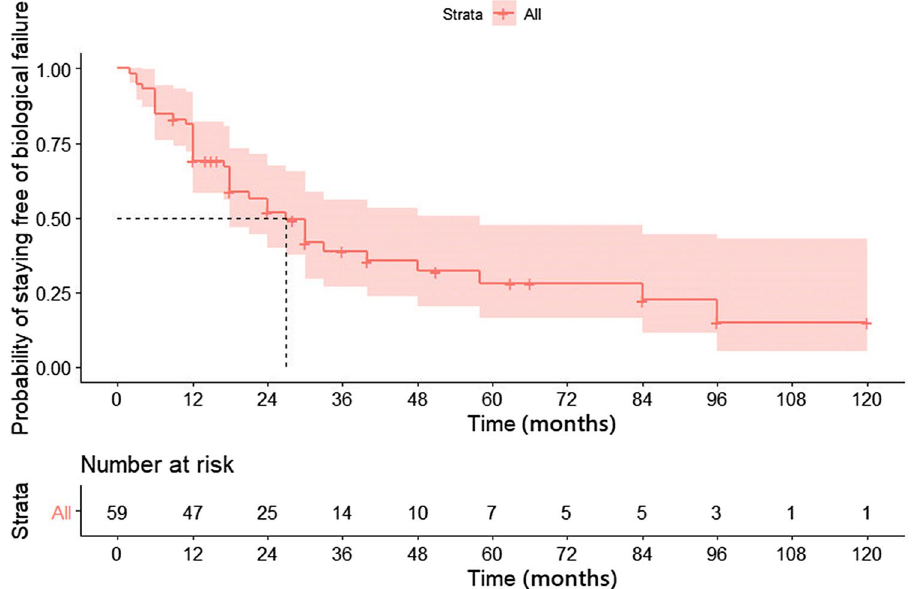
Figure 1. Kaplan Meier graph showing probability of anti TNF success in patients with stricturing Crohn’s